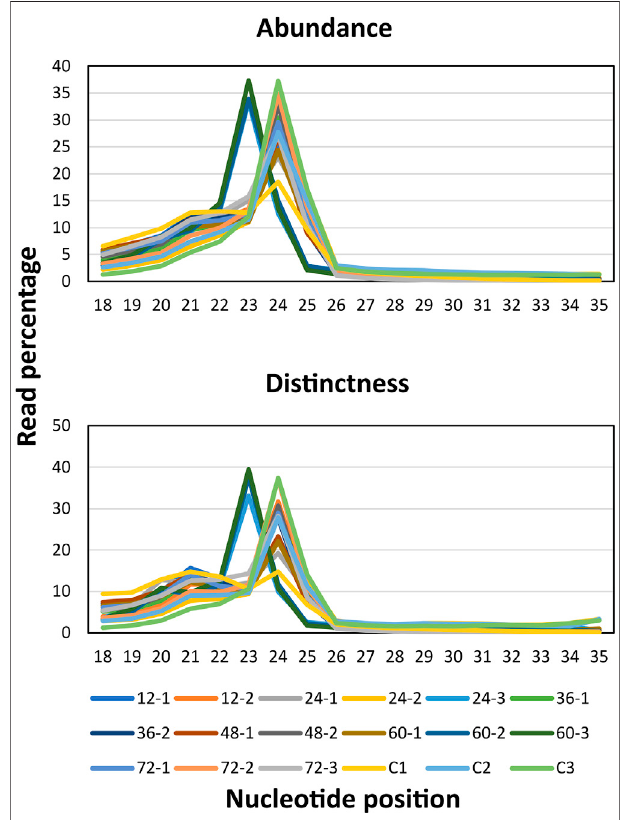
FIGURE 2 | Read abundance. The sRNA-sequencing reads were subjected for removal of the low-quality reads and adapter sequences. The clean reads were plotted by taking read length on X-axis and the percentage of the clean reads on Y-axis to observe the read abundance which highlightedallthereadsfallingwithintherangeof20 – 26 nt.Readdistinctness. Thelengthofthetotalcleanuniquereadswasplottedbytakingthereadlength on X-axis and the percentage of the clean unique reads on